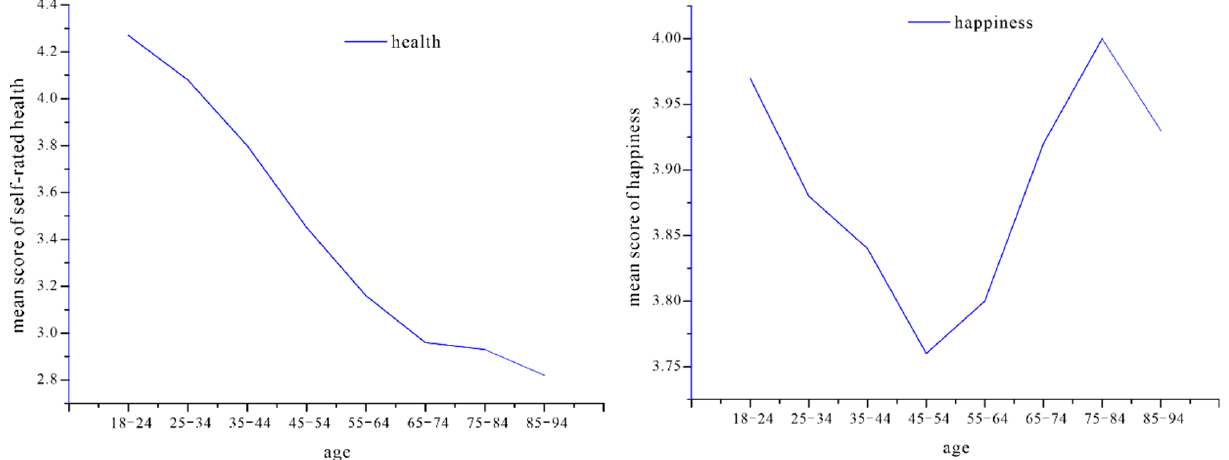
Figure 2. The change of self-rated health and happiness with aging.